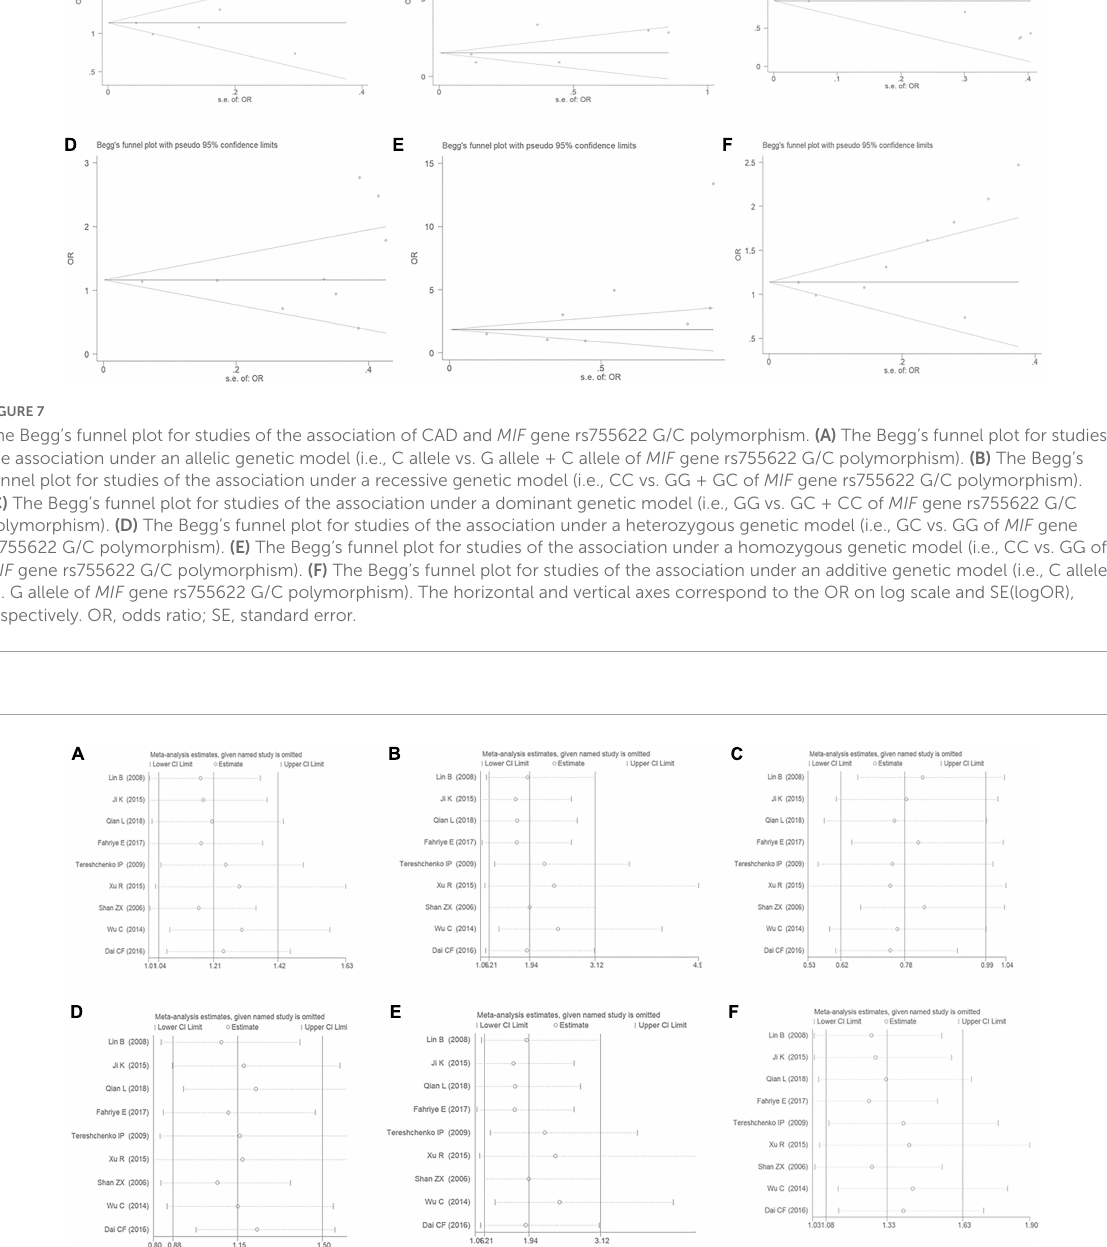
Frontiers in Cardiovascular Medicine